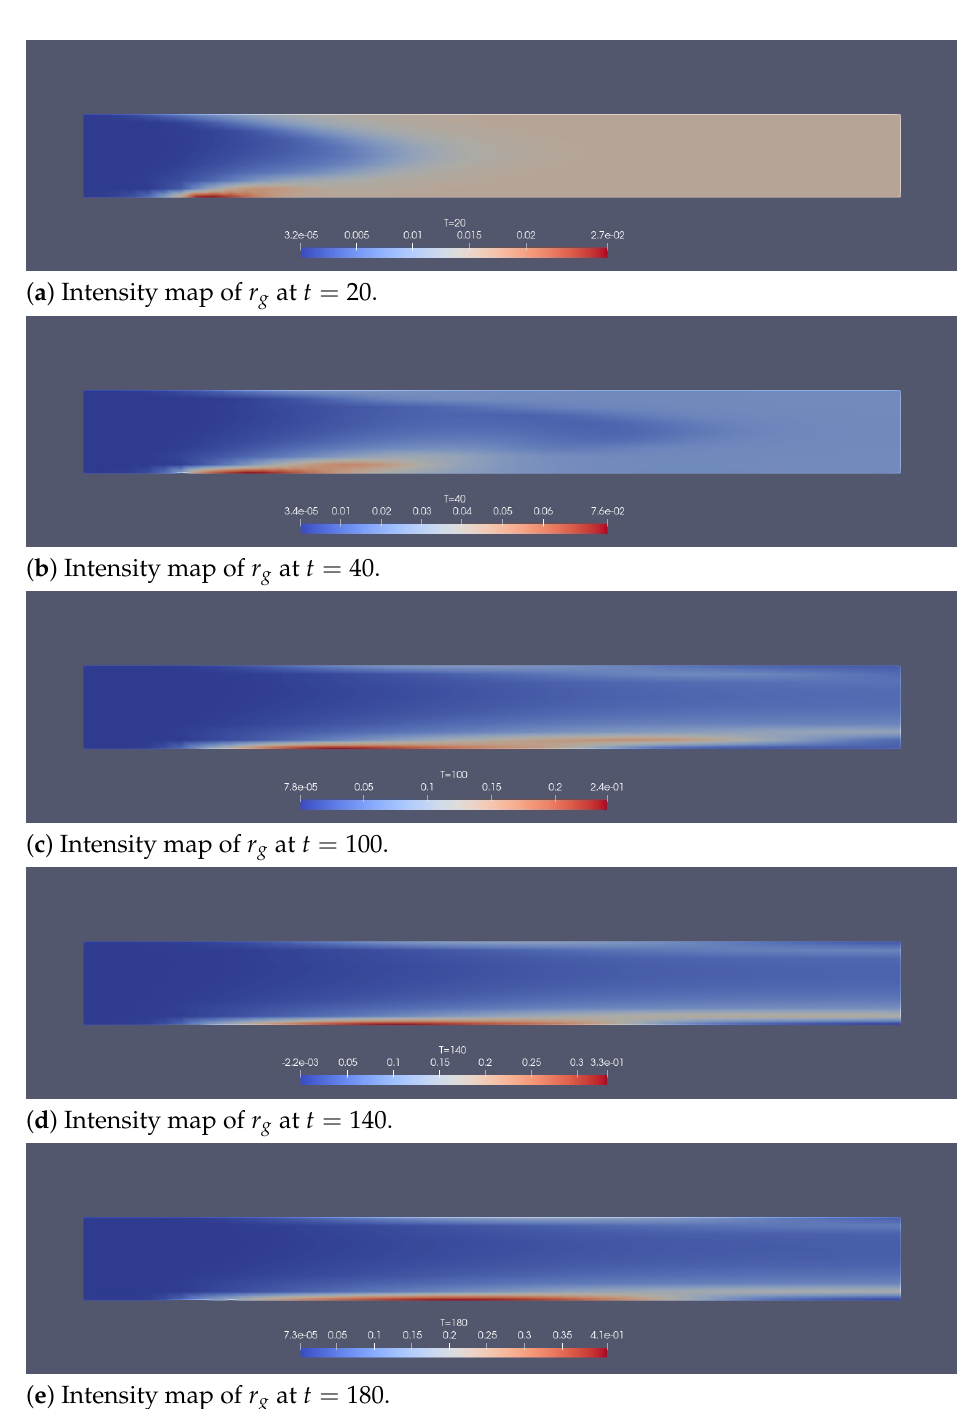
Figure 13. For Section 5.2: intensity maps of the volume fraction of the gas phase r g computed with δ t = 1 and a 100 × 10 uniform